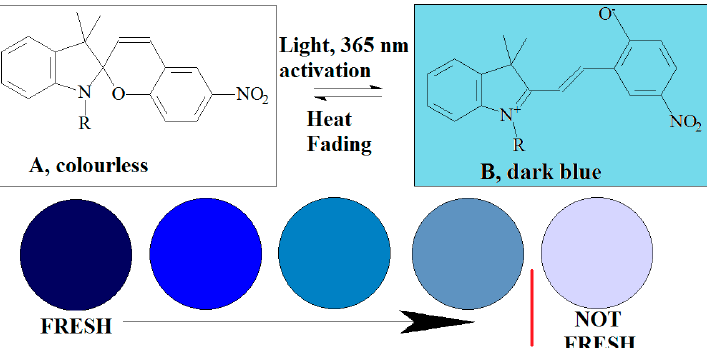
Figure 3. OnVu TTI label. The indicator is activated by UV light in the excited form (dark blue) and slowly decays back to the ground state (colorless).